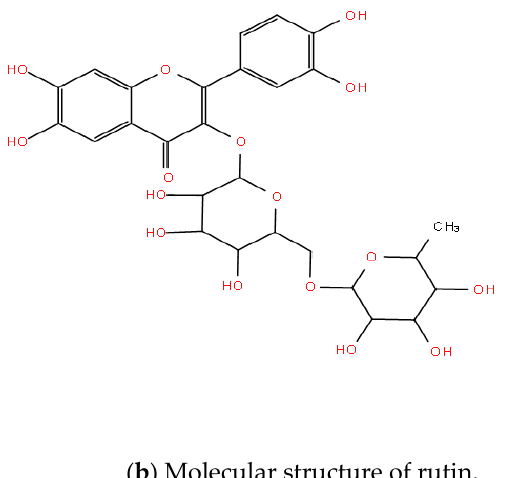
Figure 1. The basic nucleus of flavonoids and the molecular structure of rutin.